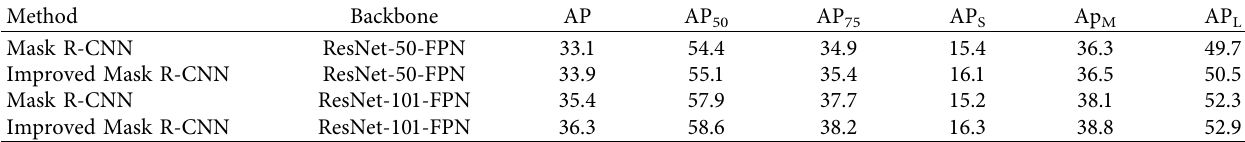
Table 4: Comparison of the two models under the coco dataset.